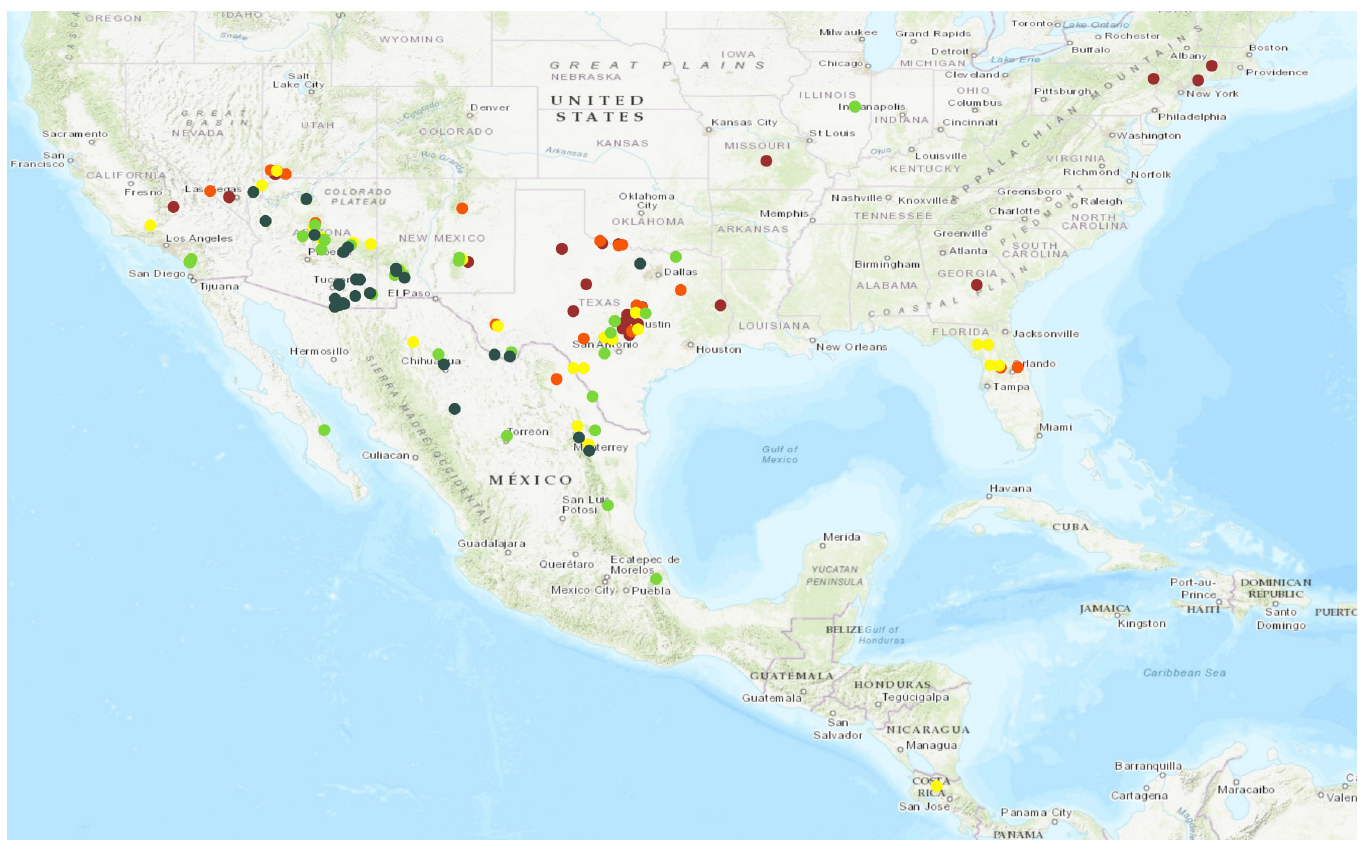
Fig 1. Graphical presentation of the PD resistance of accessions from each collection location based on ELISA readings of stem tissue after greenhouse testing. The data were grouped into five categories based on log-transformed estimations of bacterial levels: 1 = green, highly resistant (6.9–9.1); 2 = light green, resistant (9.2–11.1); 3 = yellow, moderately susceptible (11.2–13.1); 4 = orange, susceptible (13.2–15.1); and 5 = burgundy, highly susceptible (15.2 and above).